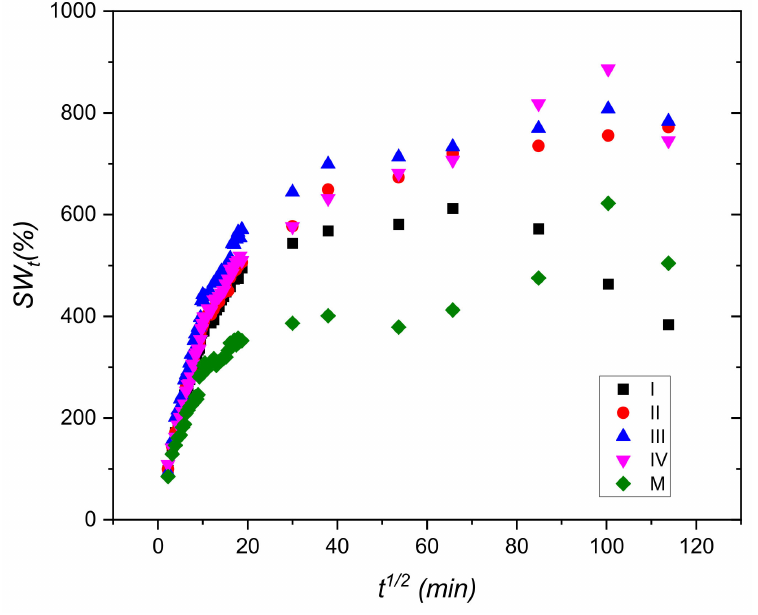
Figure 5. The dependence between SW t and t 1/2 . Representing Schott’s Equation (6), it can be observed in Figure 6, that, except for sam- ple containing 0.39% copper sulphate, one can see a linear dependence between t/SW and t , demonstrating that the swelling process follows Schott’s equation for all swelling